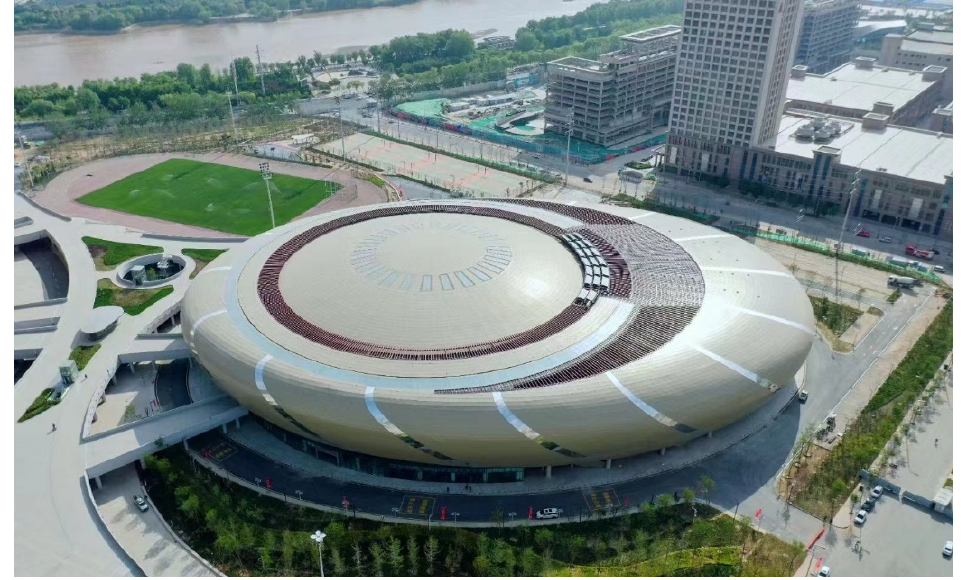
Figure 3. The Gymnasium of Lanzhou Olympic Sports Center.